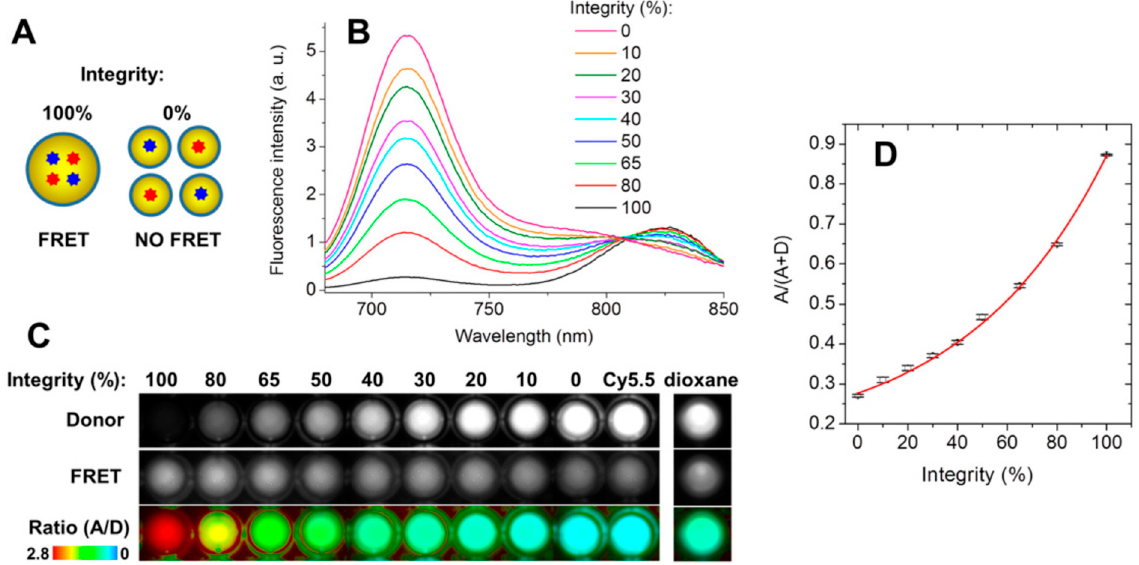
Figure 12. Calibration of ratiometric imaging using mixtures of intact FRET NCs with NCs containing donor and acceptor, respectively, at low concentrations ( A ). ( B ) Fluorescence spectra of NCs with different degree of integrity. ( C ) Fluorescence images of these mixtures. ( D ) Correlation between the A/(A + D) ratio and the level of integrity of NCs based on data in ( C ). Reproduced with permission from ref. [29]. Copyright 2016, the